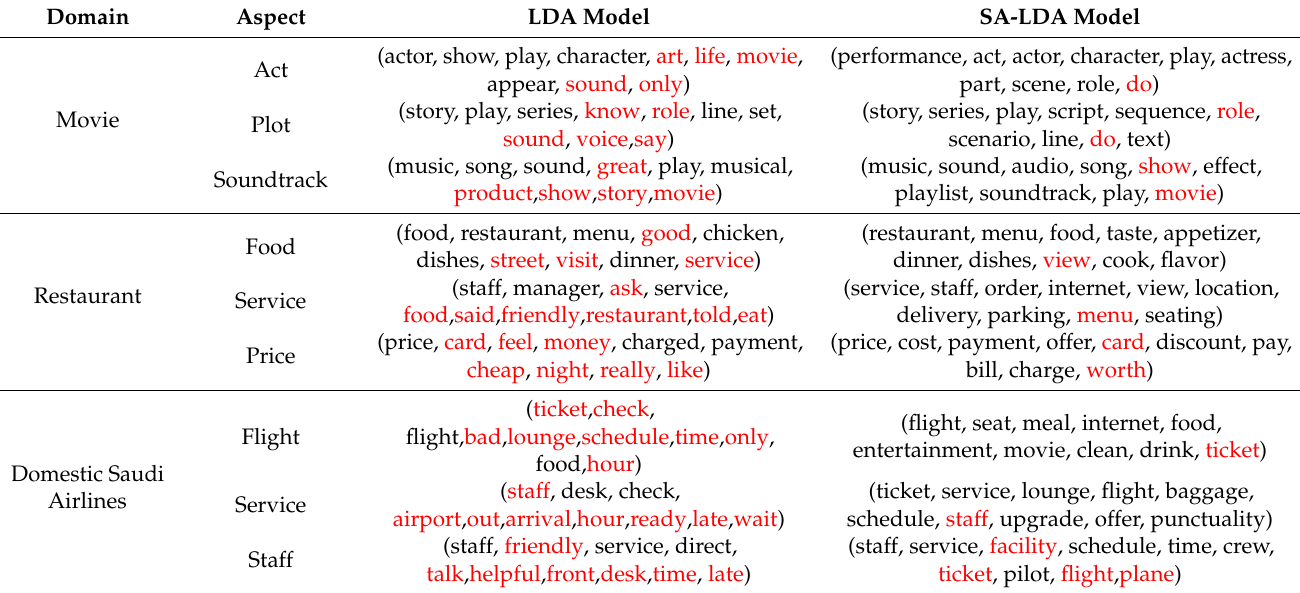
Table 3. Comparison between the proposed topic modelling results and the based topic modelling algorithm.